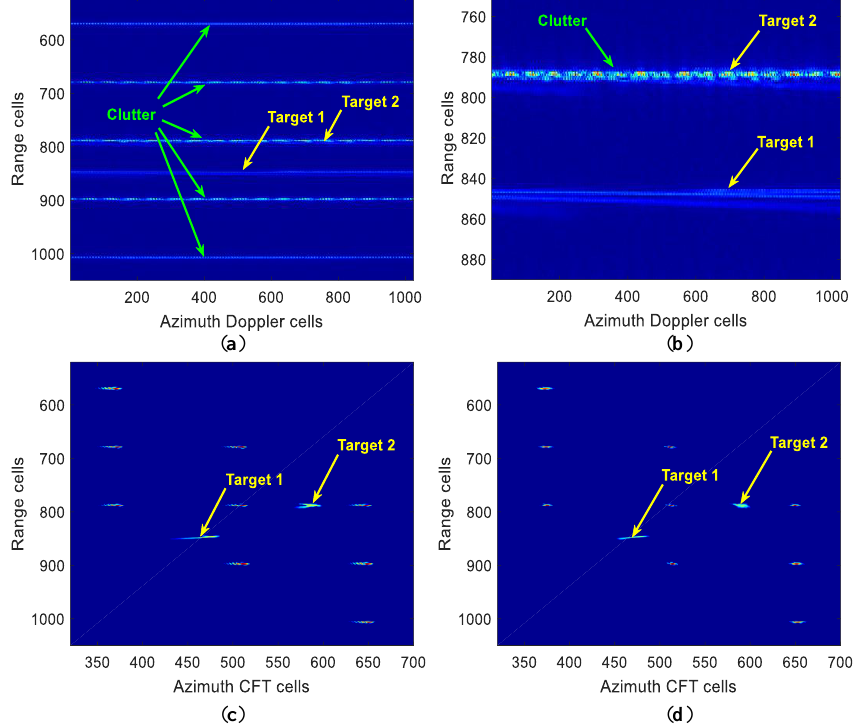
Figure 12. Results in the range compression and azimuth Doppler frequency domain. ( a ) After azimuth FT. ( b ) Local enlarge results in ( a ). ( c ) After azimuth second-order CFT. ( d ) After cubic CFT in